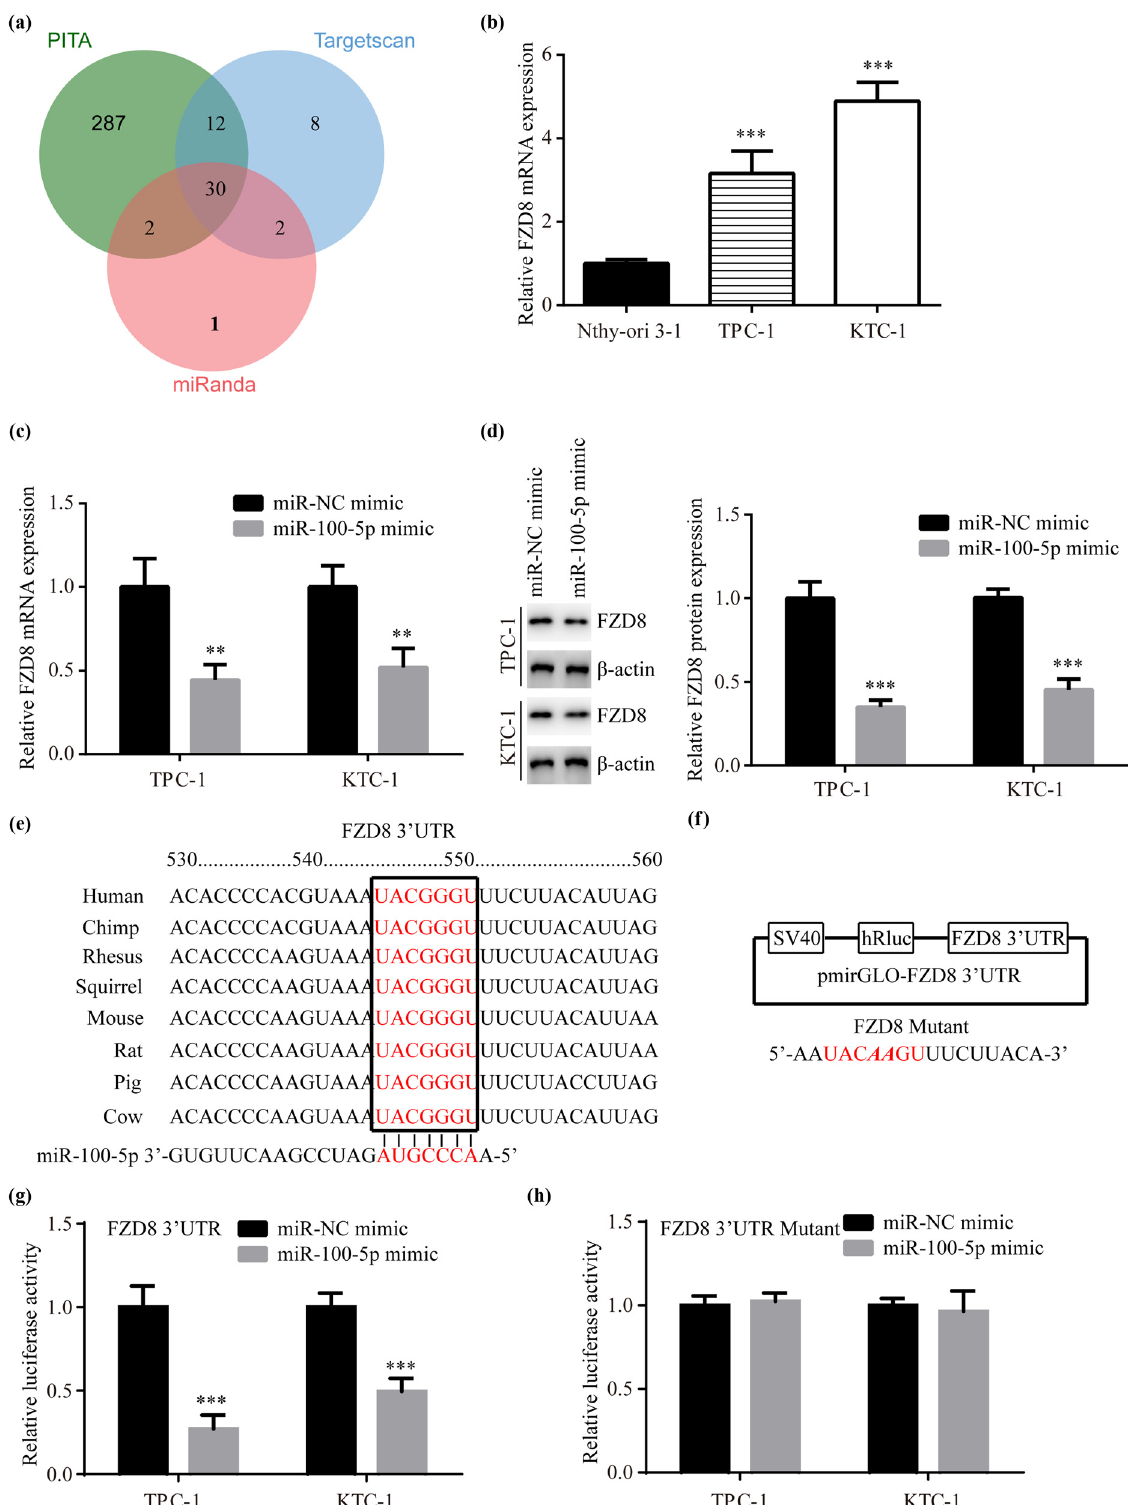
Figure 3: FZD8 was a target for miR - 100 - 5p: ( a ) the targets of miR - 100 - 5p were predicted using PITA, TargetScan7.2, and miRanda. The overlapping of the targets is presented in a vein map, ( b ) RT - PCR showed that FZD8 mRNA levels were increased in TPC - 1 and KTC - 1 compared to Nthy - ori3 - 1, ( c ) RT - PCR presented that miR - 100 - 5p mimic decreased FZD8 mRNA levels in TPC - 1 and KTC - 1, ( d ) western blotting revealed that miR - 100 - 5p mimic decreased FZD8 protein levels in TPC - 1 and KTC - 1, ( e ) the conserved binding sites for miR - 100 - 5p on FZD8 mRNA are presented, ( f ) FZD8 3 ′ UTR and its mutant form was inserted into pmirGLO plasmid, respectively, and ( g and h ) luciferase assay revealed that miR - 100 - 5p reduced luciferase activity of FZD8 3 ′ UTR but not FZD8 3 ′ UTR Mutant in TPC - 1 and KTC - 1. **, p < 0.01 and ***, p <